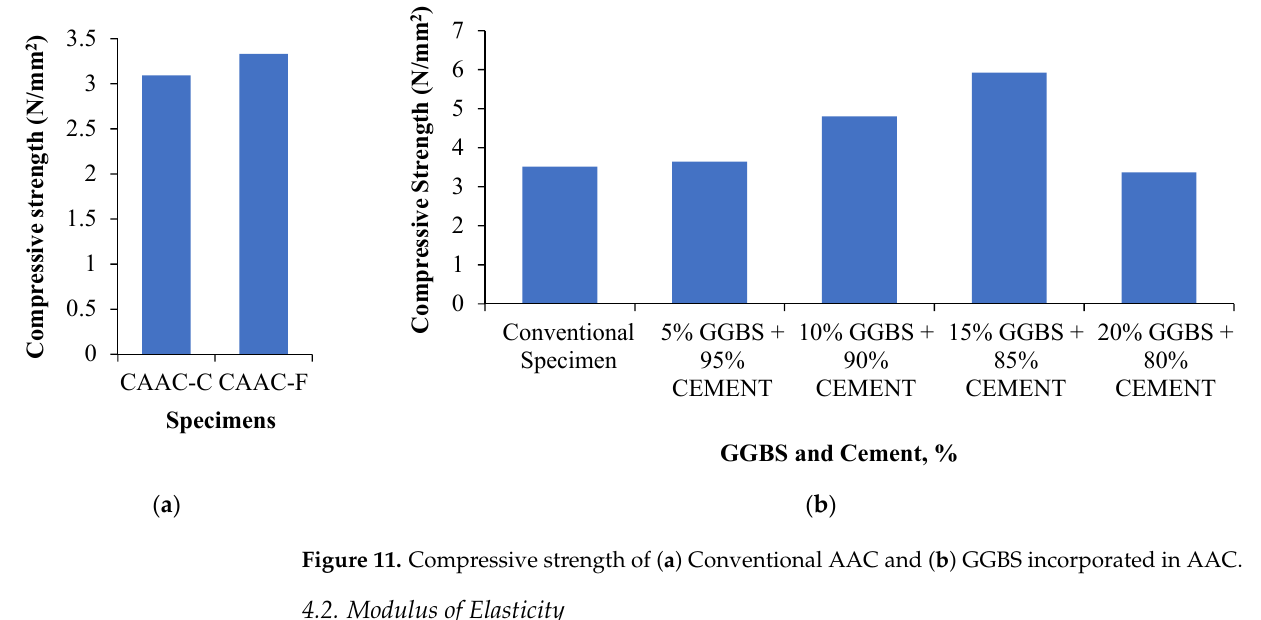
Figure 11. Compressive strength of ( a ) Conventional AAC and ( b ) GGBS incorporated in AAC. From the test results, we observed Class F fly ash-based AAC compressive strength was around 9% higher than that of Class C fly ash. The presence of a high range of silica in Class F fly ash enhances the compressive strength of conventional aerated concrete when compared to Class C fly ash. For the dosage of GGBS incorporated AAC blocks, the strength increased around 3.6% for G5C95 specimens, 37% strength increased for G10C90 specimens, 68.6% strength increased for G15C85 specimens, and 4% strength decreased for G20C80 specimens.